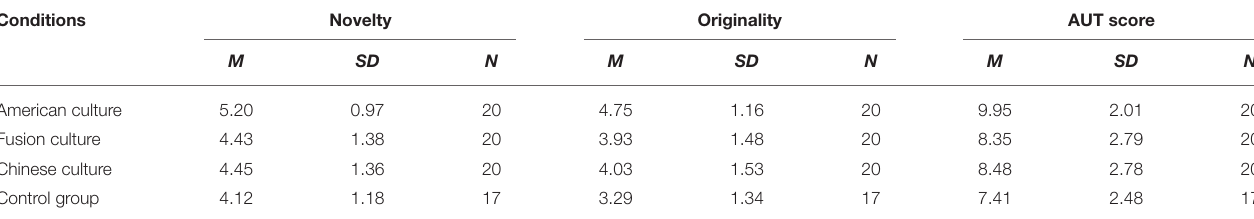
TABLE 1 | The total score and dimension score of the story-writing task under the conditions of cultural priming. Conditions Novelty